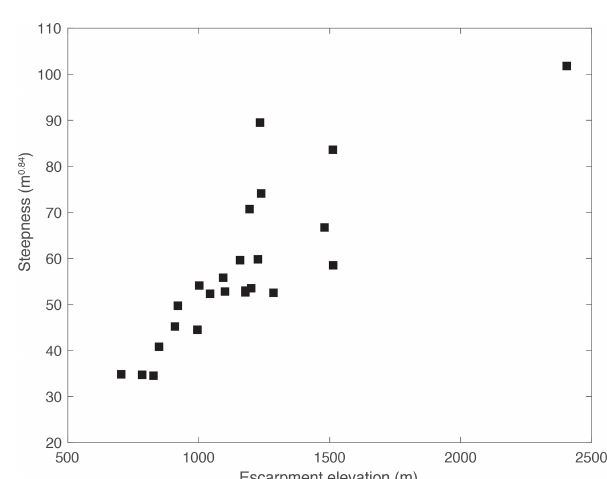
Figure 14. Relationship between channel steepness and escarpment height in the Western Ghats. The channel steepness is calculated from slope–area plots using a uniform concavity of 0.42. Correla- tion is consistent with the theory that morphology has evolved to erode pre-existing topography at a constant rate of retreat. See Ta- ble 1 for the